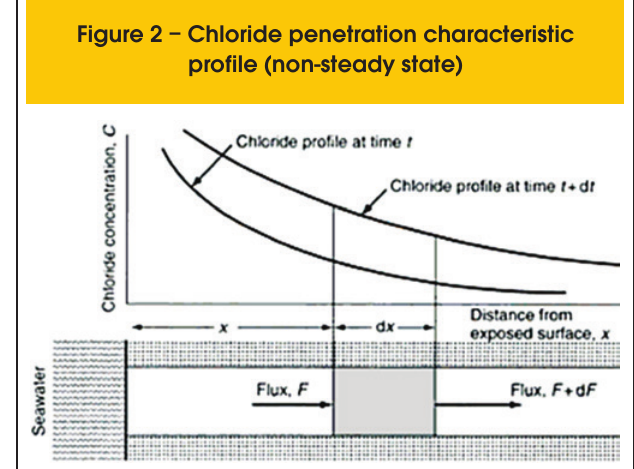
Figure 2 – Chloride penetration characteristic profile (non-steady